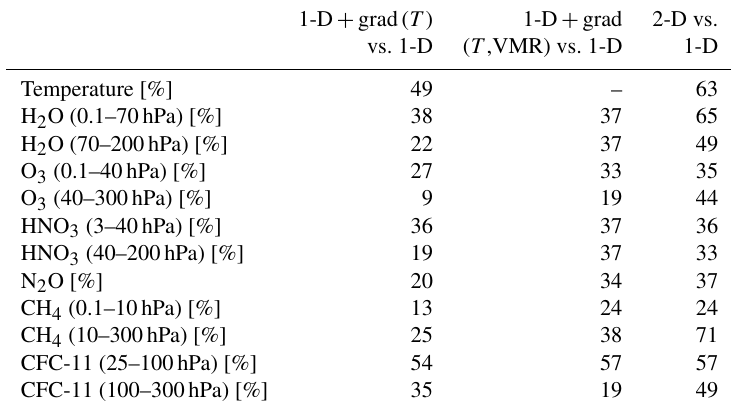
Table 2. RMSE improvements due to different treatments of horizontal inhomogeneities (1-D + grad( T ), 1-D + grad( T ,VMR), 2-D) for each target with respect to